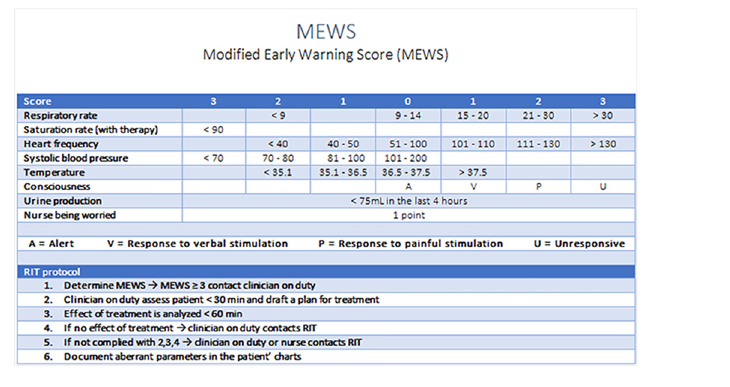
Fig 1. MEWS and protocol in